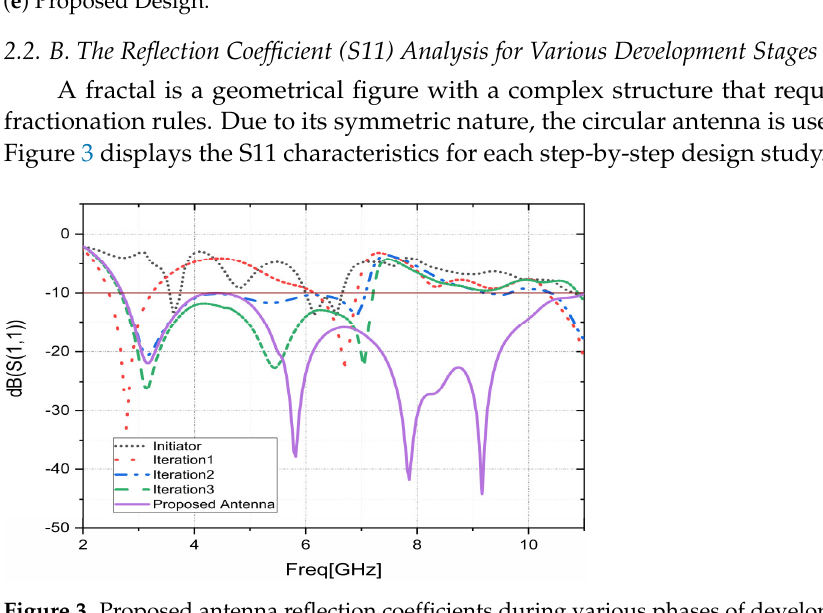
Figure 3. Proposed antenna reflection coefficients during various phases of development. Table 2. Frequency bands that the suggested antenna would cover.